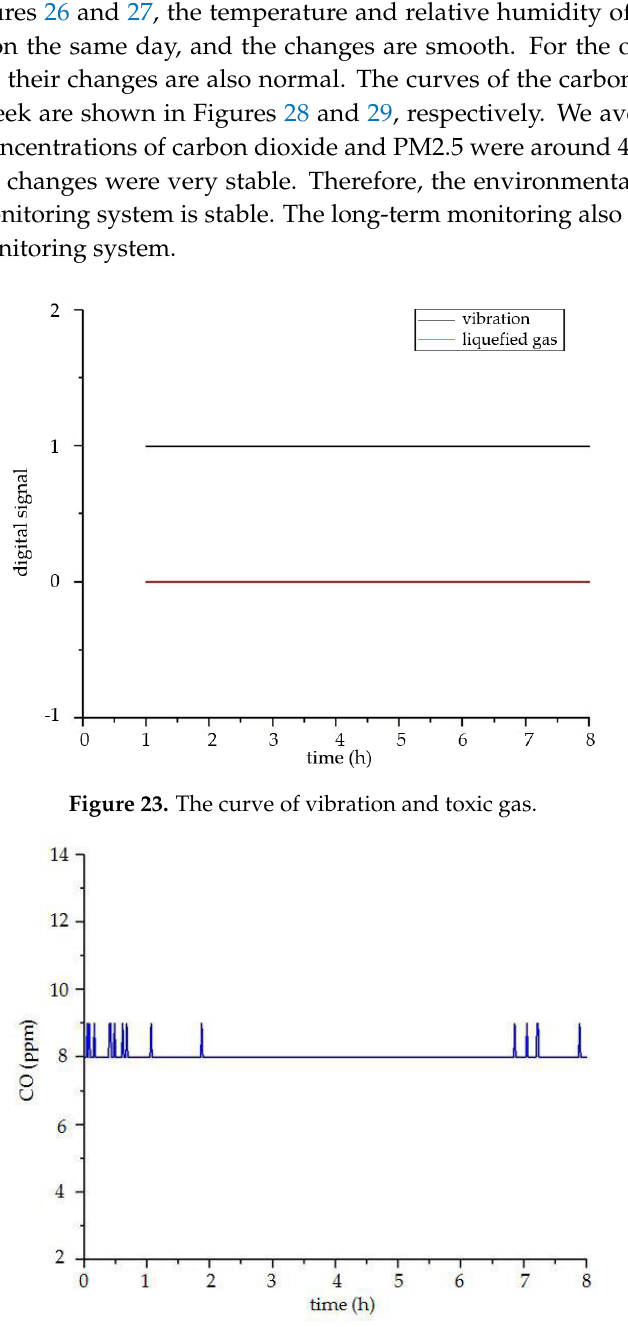
Figure 24. The curve of carbon monoxide concentration.